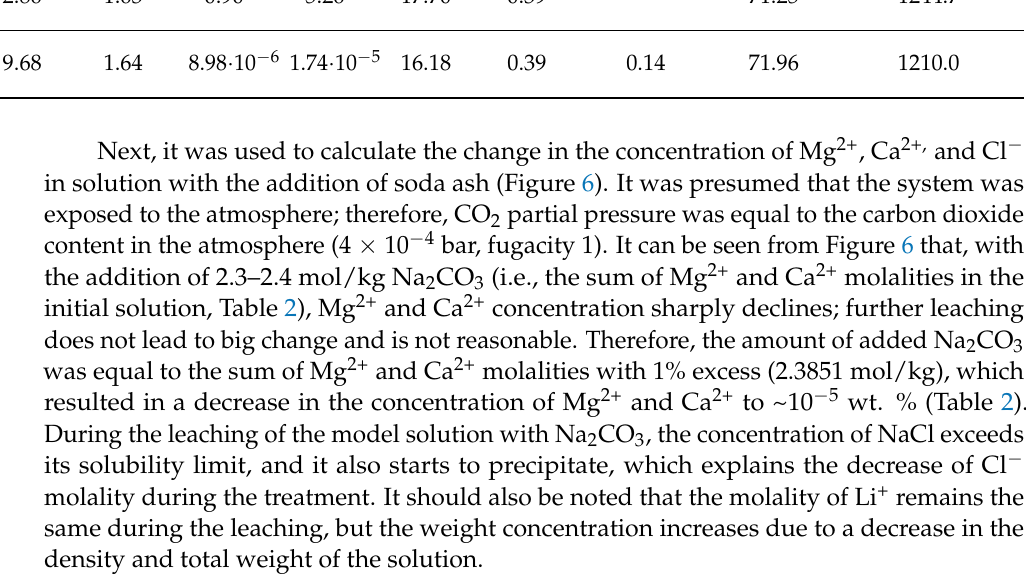
Density, kg/m 3 Li